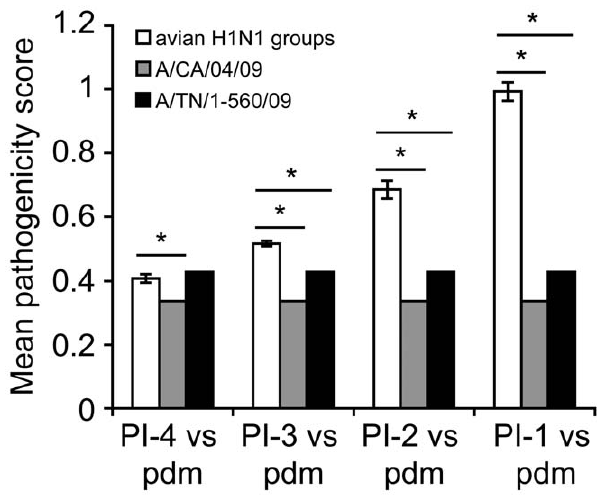
Figure 1. Comparison of the mean pathogenicity scores of each pathogenicity index (PI) category. Each avian H1N1 virus and the 2009 pandemic strains were assigned to a PI category based on their total pathogenicity score in DBA/2J mice. The PI-4 category includes the most pathogenic isolates; PI-3, moderately pathogenic isolates; PI-2, low pathogenic isolates; and PI-1, least pathogenic isolates. (* P , 0.05 ).